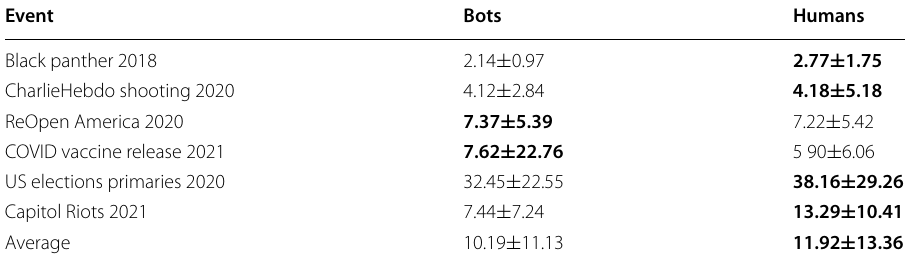
Table 4 Average CSI-User by user type